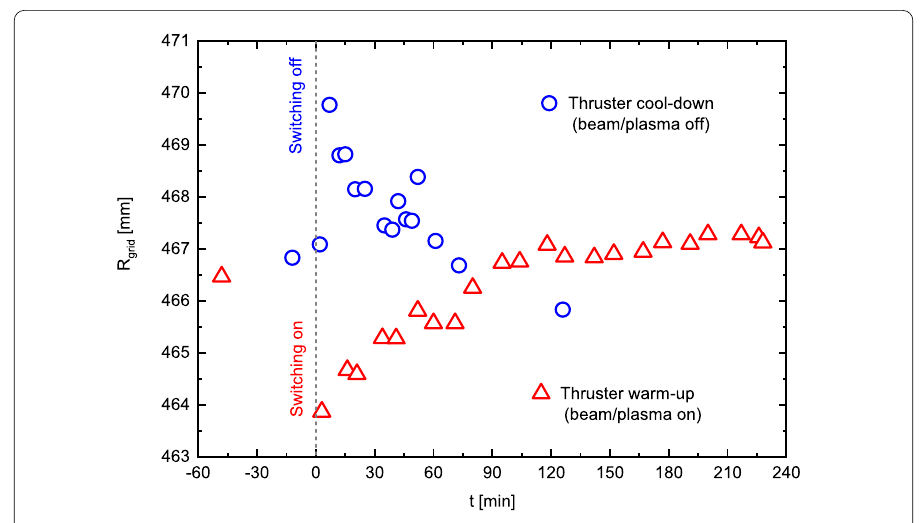
Figure 12 Grid curvature versus operation time for the warm-up phase (red triangles) and cool-down phase (blue circles) of the RIT-22. Before switching the beam on, the plasma was burning for about 2 hours. (Thruster power level: 1.25